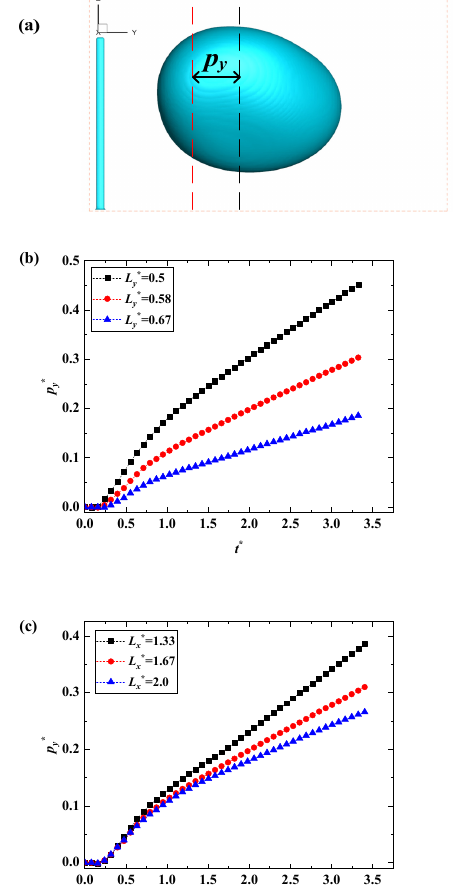
Figure 14. ( a ) The droplet morphology after bouncing off the S2 surface. ( b ) The dimensionless p y * as a function of time at a fixed L x * = 1.67. ( c ) The dimensionless p y * as a function of time at a fixed L y * = 0.58.